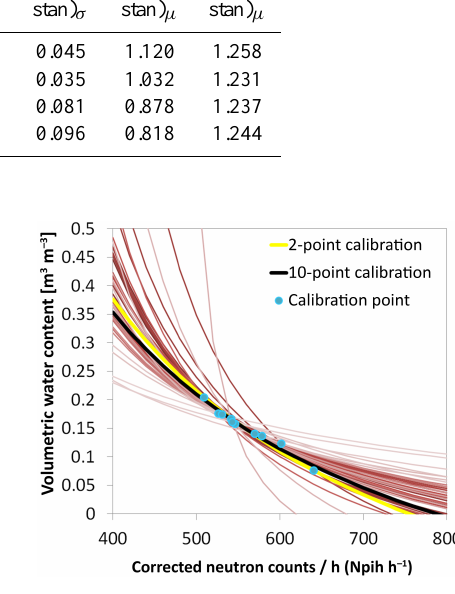
Figure 8. Best-fit N 0 -calibration functions (red-brown colored lines) for all combinations of two-point calibrations (blue dots). Best-fit N 0 -calibration function for 10-point calibration (black line). Best-fit two-point N 0 -calibration function derived from calibration points with the highest and lowest volumetric water content (yellow